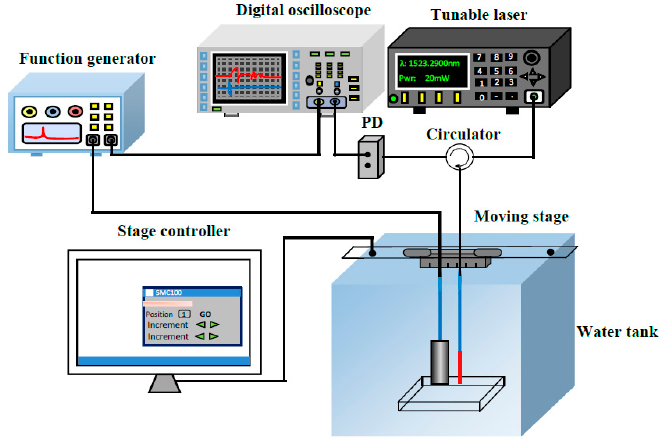
Figure 5. Schematic diagram of fiber-optic ultrasonic detection system.